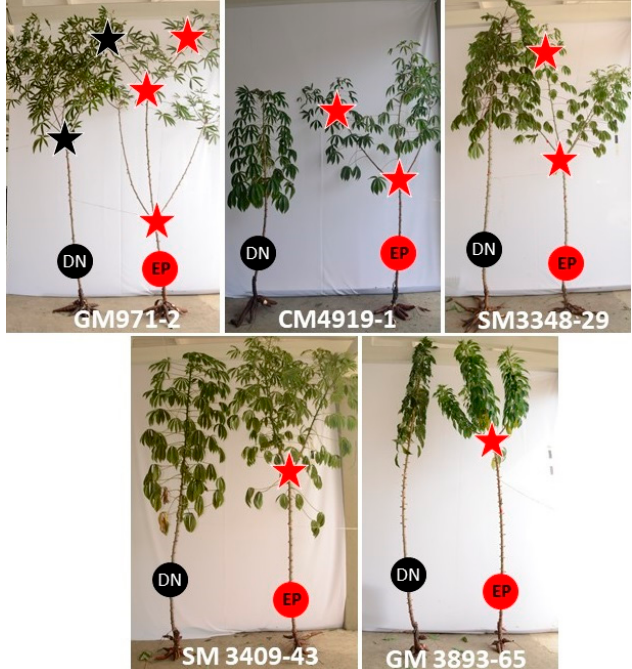
Figure 3. Comparison of plants grown under dark night (DN) and extended photoperiod (EP) for each of the five genotypes included in Experiment 1. For each genotype, plants were randomly selected from DN (left plant in each photograph) or EP plots (right plant in each photograph). Branching events are highlighted with black or red stars respectively for DN and EP.